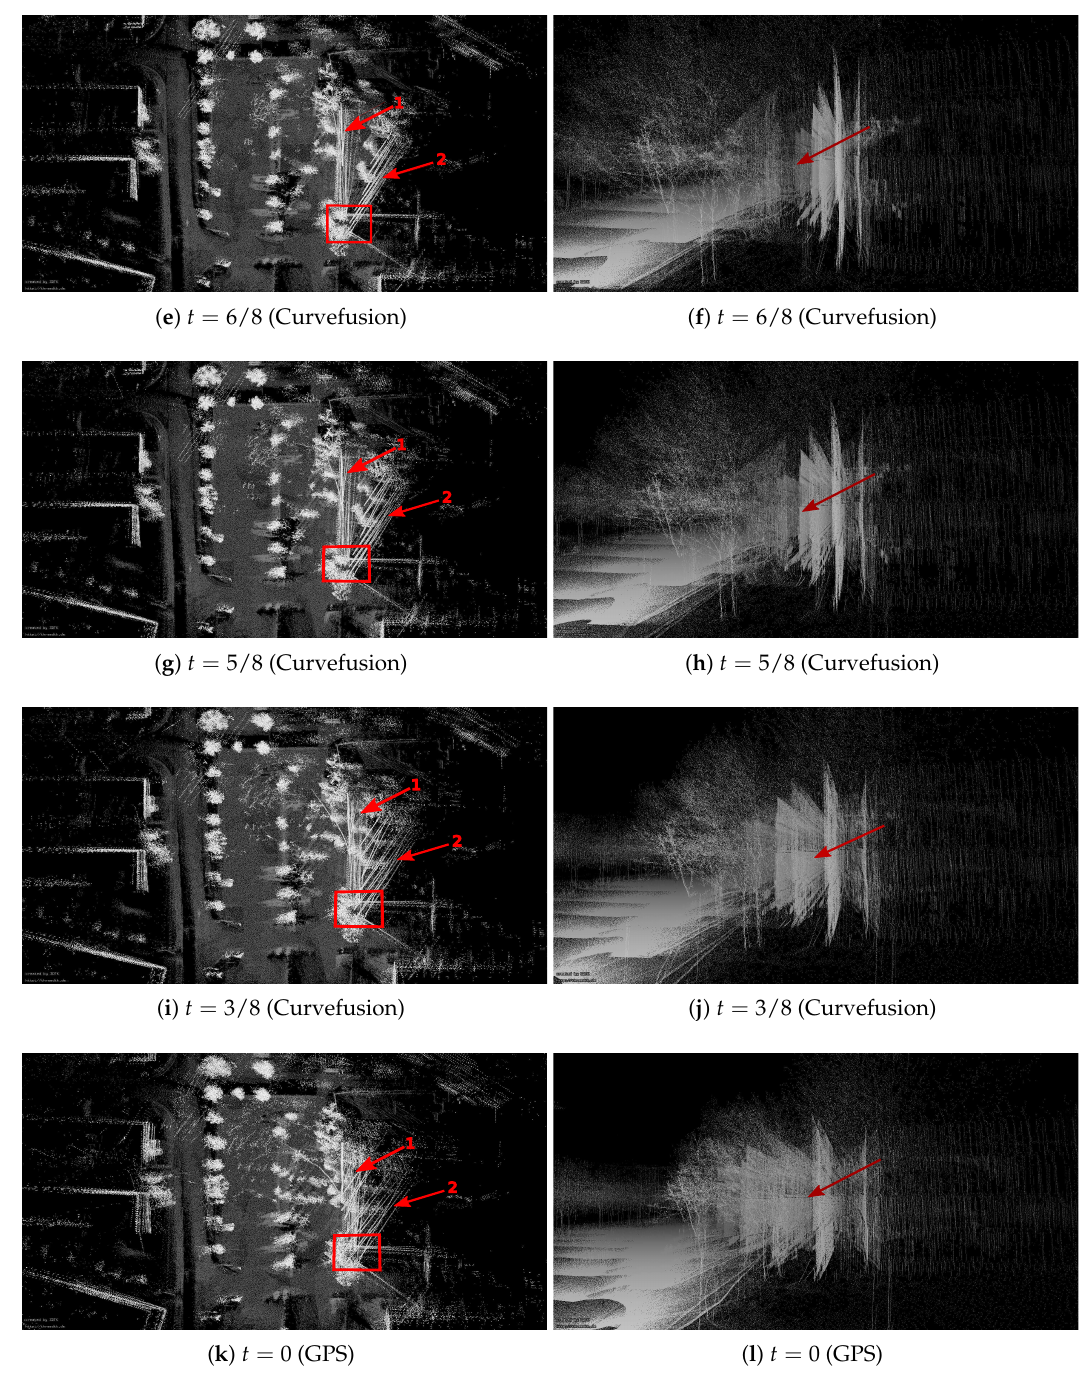
Figure 8. Visual inspection of the parking lot data sets. Left column: 3D point cloud results from bird’s eye view. Right column: corresponding perspective views marked with the red rectangle on the left